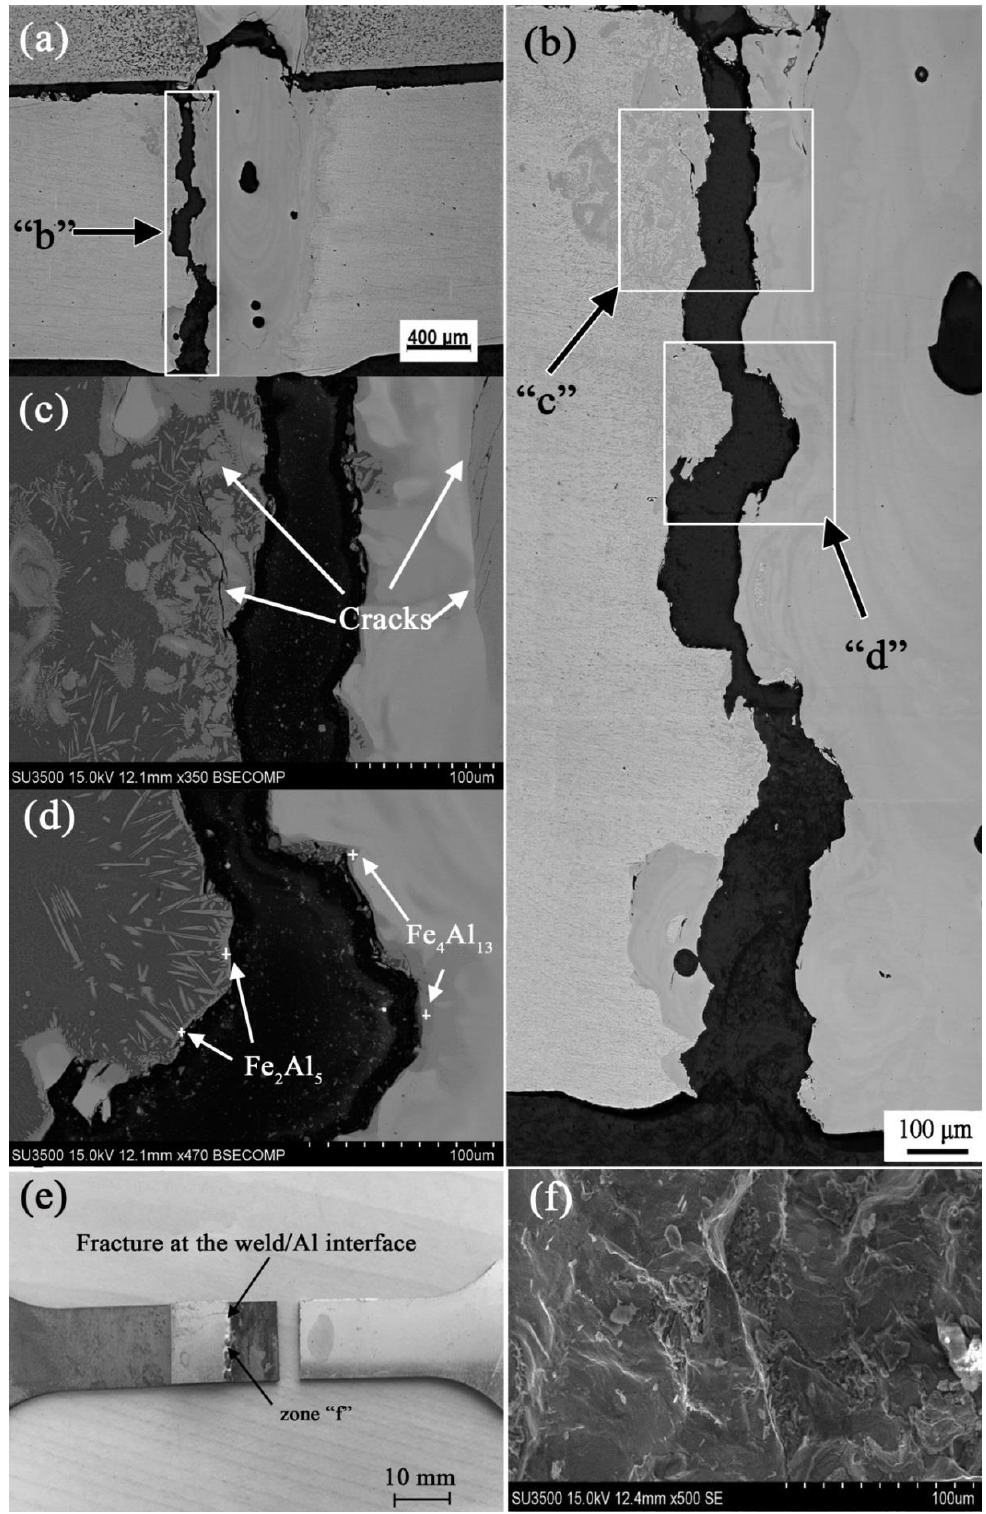
Figure 12. Fracture path morphology of steel/Al joints having an over-deep P2 of 1741 µ m produced by dual-beam laser welding with side-by-side configuration arrangement: ( a ) Macroscopic fractured steel/Al joint; ( b ) High magnification of fracture path and locations of Zones “c” and “d”; ( c ) BSE image of enlarged view of Zone “c”; ( d ) BSE image of enlarged view of Zone “d”; ( e ) Macroscopic fractured steel/Al joints; ( f ) Fracture surface of Zone “f” in ( e ).